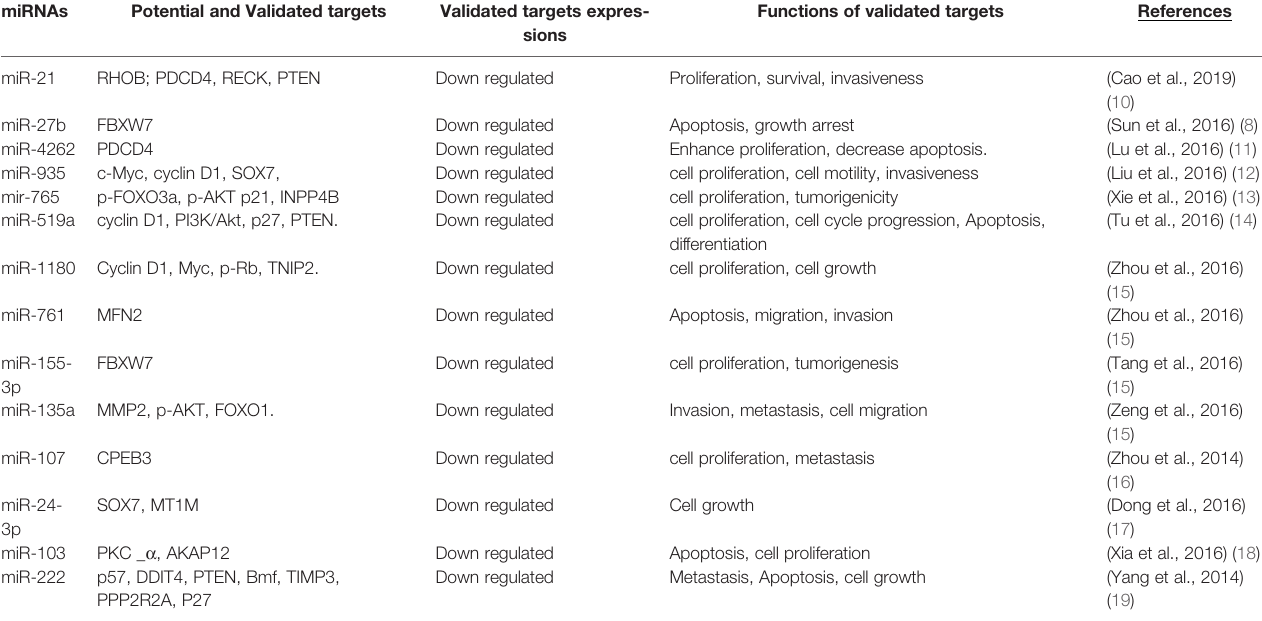
TABLE 1 | Up regulated miRNAs and their target genes in hepatocellular carcinoma. miRNAs Potential and Validated targets Validated targets expres-